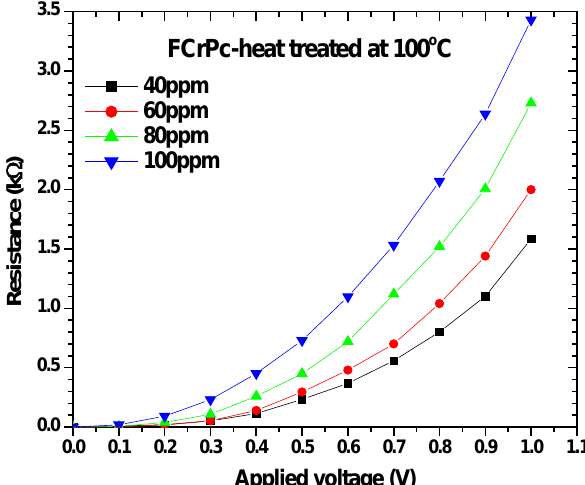
Figure 6. Resistance versus Applied Voltage (R-V) characteristics of FCrPc deposited and treated at 100 °C with different NH3 concentrations.